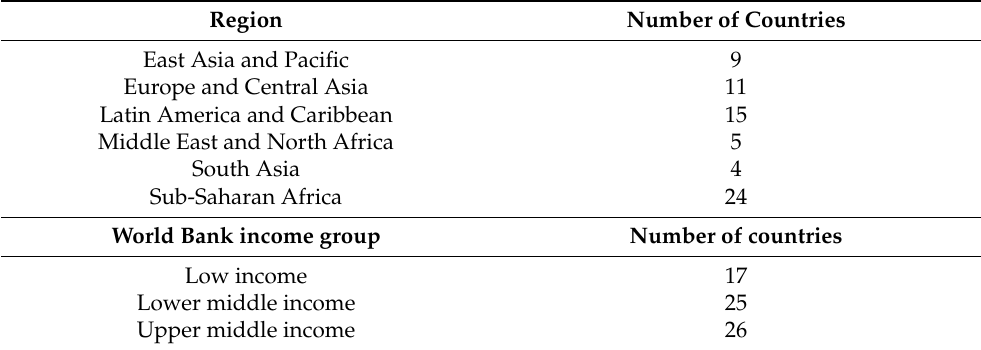
Table 2. Number of countries included by the World Health Organization (WHO) region and World Bank income group. Region Number of Countries East Asia and Pacific 9 Europe and Central Asia 11 Latin America and Caribbean 15 Middle East and North Africa 5 South Asia 4 Sub-Saharan Africa 24 World Bank income group Number of countries Low income 17 Lower middle income 25 Upper middle income